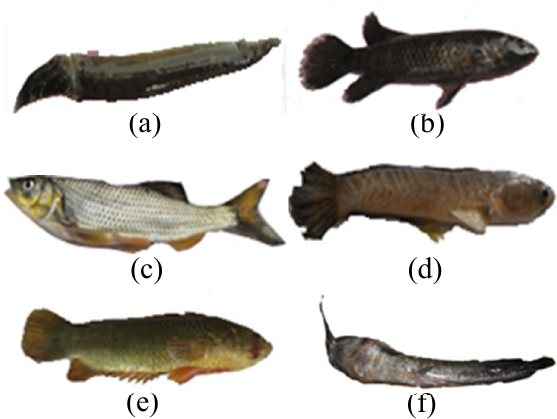
Figure 3. Fishes collected from Murti River (the comparatively less polluted reference site) free from parasitic infection: (a) Mastecembelus armatus , (b) Badis sp., (c) Barilius bendelisis ; fishes (from polluted water bodies) infected with parasites: (d) Channa sp., (e) Anabas sp. and (f) Clarias sp.